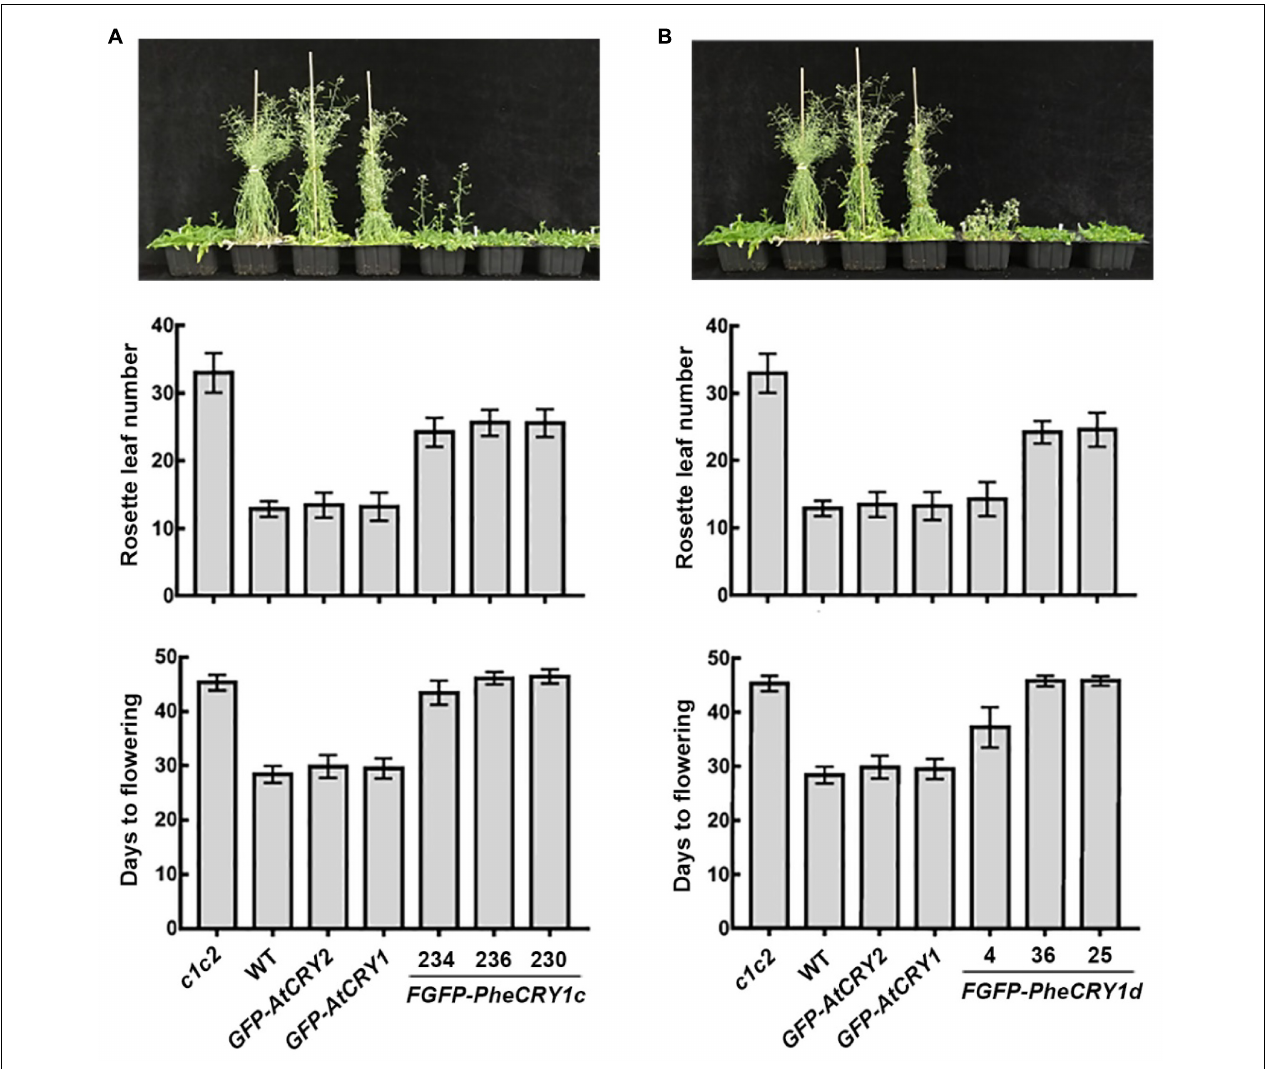
FIGURE 2 | Bamboo PheCRY1 doesn’t function in the flowering time regulation in Arabidopsis . (A,B) Images of the flowering phenotypes of indicated plants grown in LD (16 h light/8 h dark) were shown. Rosette leaf numbers and days to flowering were recorded when flowering. Data were shown as mean ± SD, n ≥